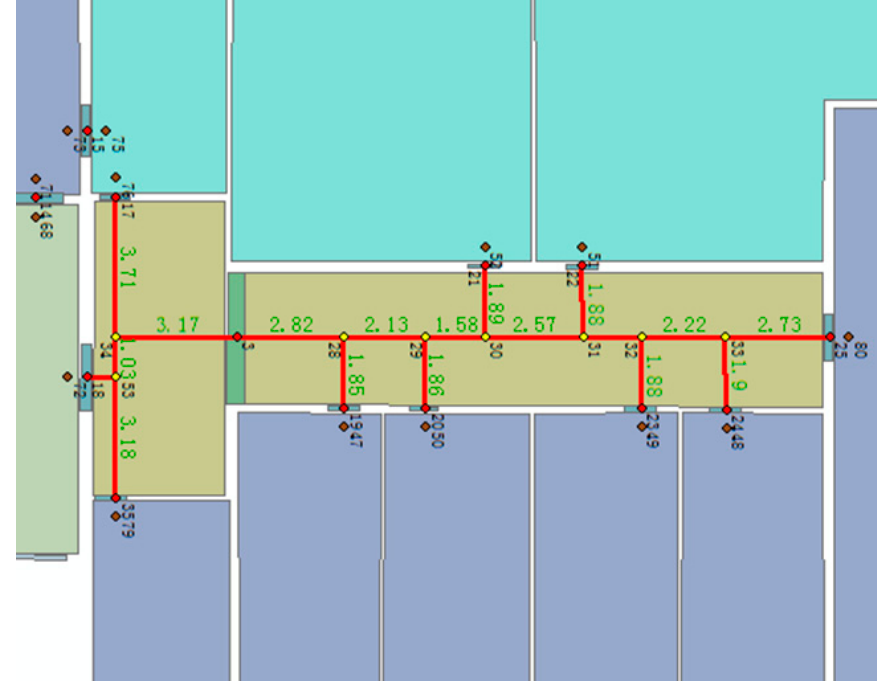
Figure 5. The semantic augmented route network graph in the corridor region. The red line is the corridor skeleton indicating the potential user path. The yellow points segment the corridor line by connecting it with the possible turns into a room. The red points represent doors connecting two regions. The brown points indicate two-dimensional areas such as rooms or larger open areas. The numbers indicate the length of the lines. Table 1. Example of the data structure of the corresponding graph in Figure 5.